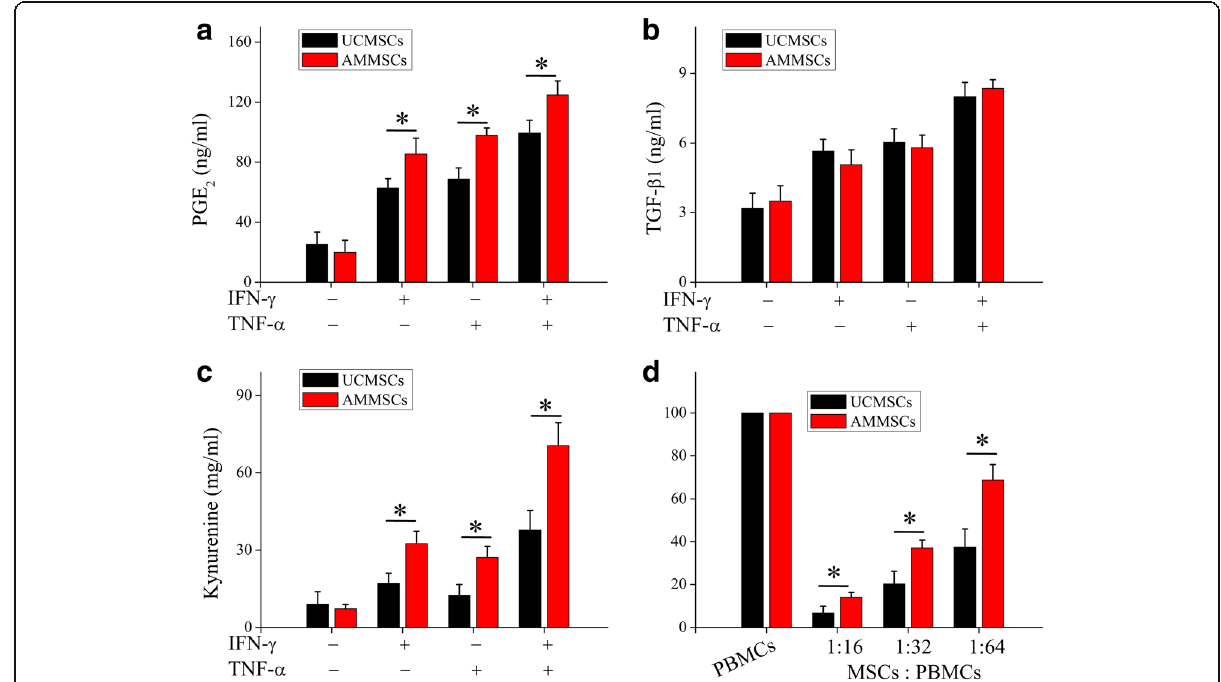
Fig. 6 AMMSCs in PL showed superior immunosuppression effects with UCMSCs. When primed by IFN- γ and/or TNF- α induction, PGE 2 ( a ) and TGF- β 1 ( b ) expression were analyzed. IDO activity ( c ) was evaluated by kynurenine levels. ( d ) UCMSCs suppressed allogeneic lymphocyte proliferation. Bars represented means ± SD, n =5; * P